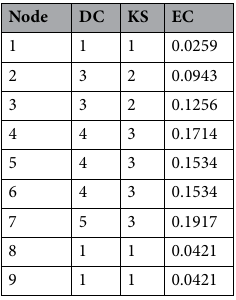
Table 1. The degree value, k -shell value and eigenvector centrality value of each node in the toy network.